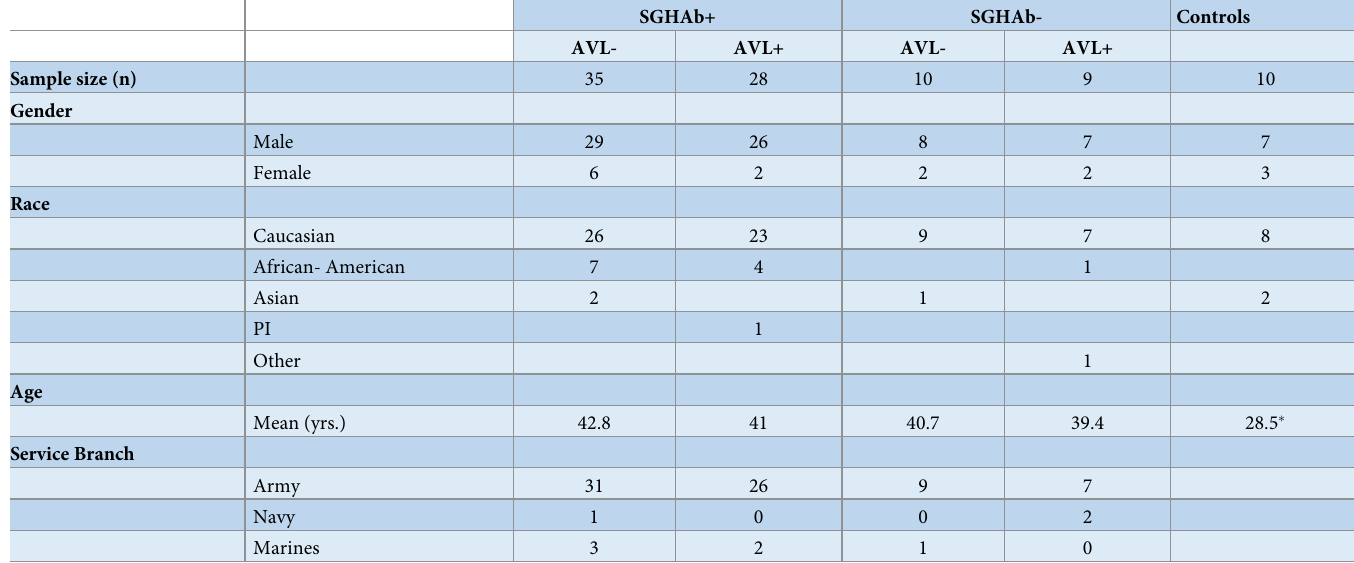
Table 1. Demographic Characteristics of the Study